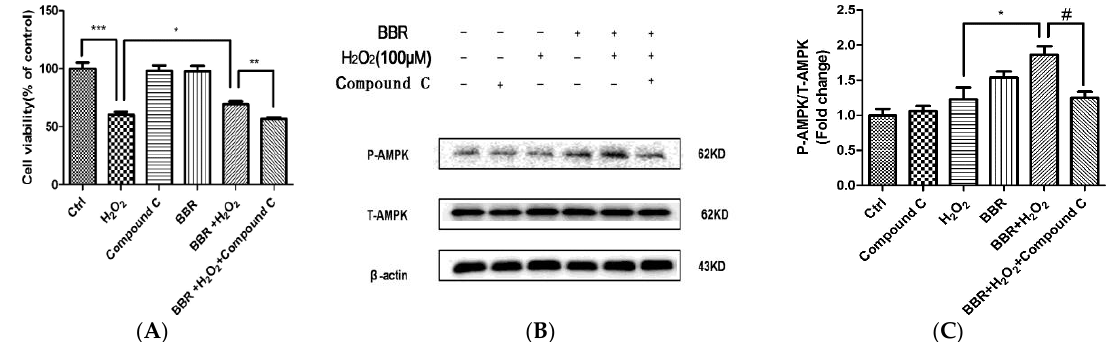
Figure 6. AMPK specific inhibitor Compound C blocked the protective effect of BBR in D407 cells. ( A ) D407 cells were pre-treated with 5 µM Compound C for 30 min and 3 µM BBR for 2 h and then incubated with or without H 2 O 2 for a further 24 h. Cell viability was measured by MTT assay. * indicates p < 0.05. ** indicates p < 0.01, *** indicates p < 0.001 was considered significantly different; ( B ) D407 cells were pre-treated with 5 µM Compound C for 30 min and 3 µM BBR for 80 min and then incubated with or without H 2 O 2 for a further 2 h. The expression of phosphorylated AMPK, total AMPK, and β-actin were detected by Western blotting with specific antibodies; ( C ) Quantification of representative protein band from Western blotting. * indicates p < 0.05versus the H 2 O 2 group was considered significantly different. # indicates p < 0.05 versus the BBR + H 2 O 2 -treated group was considered significantly different.